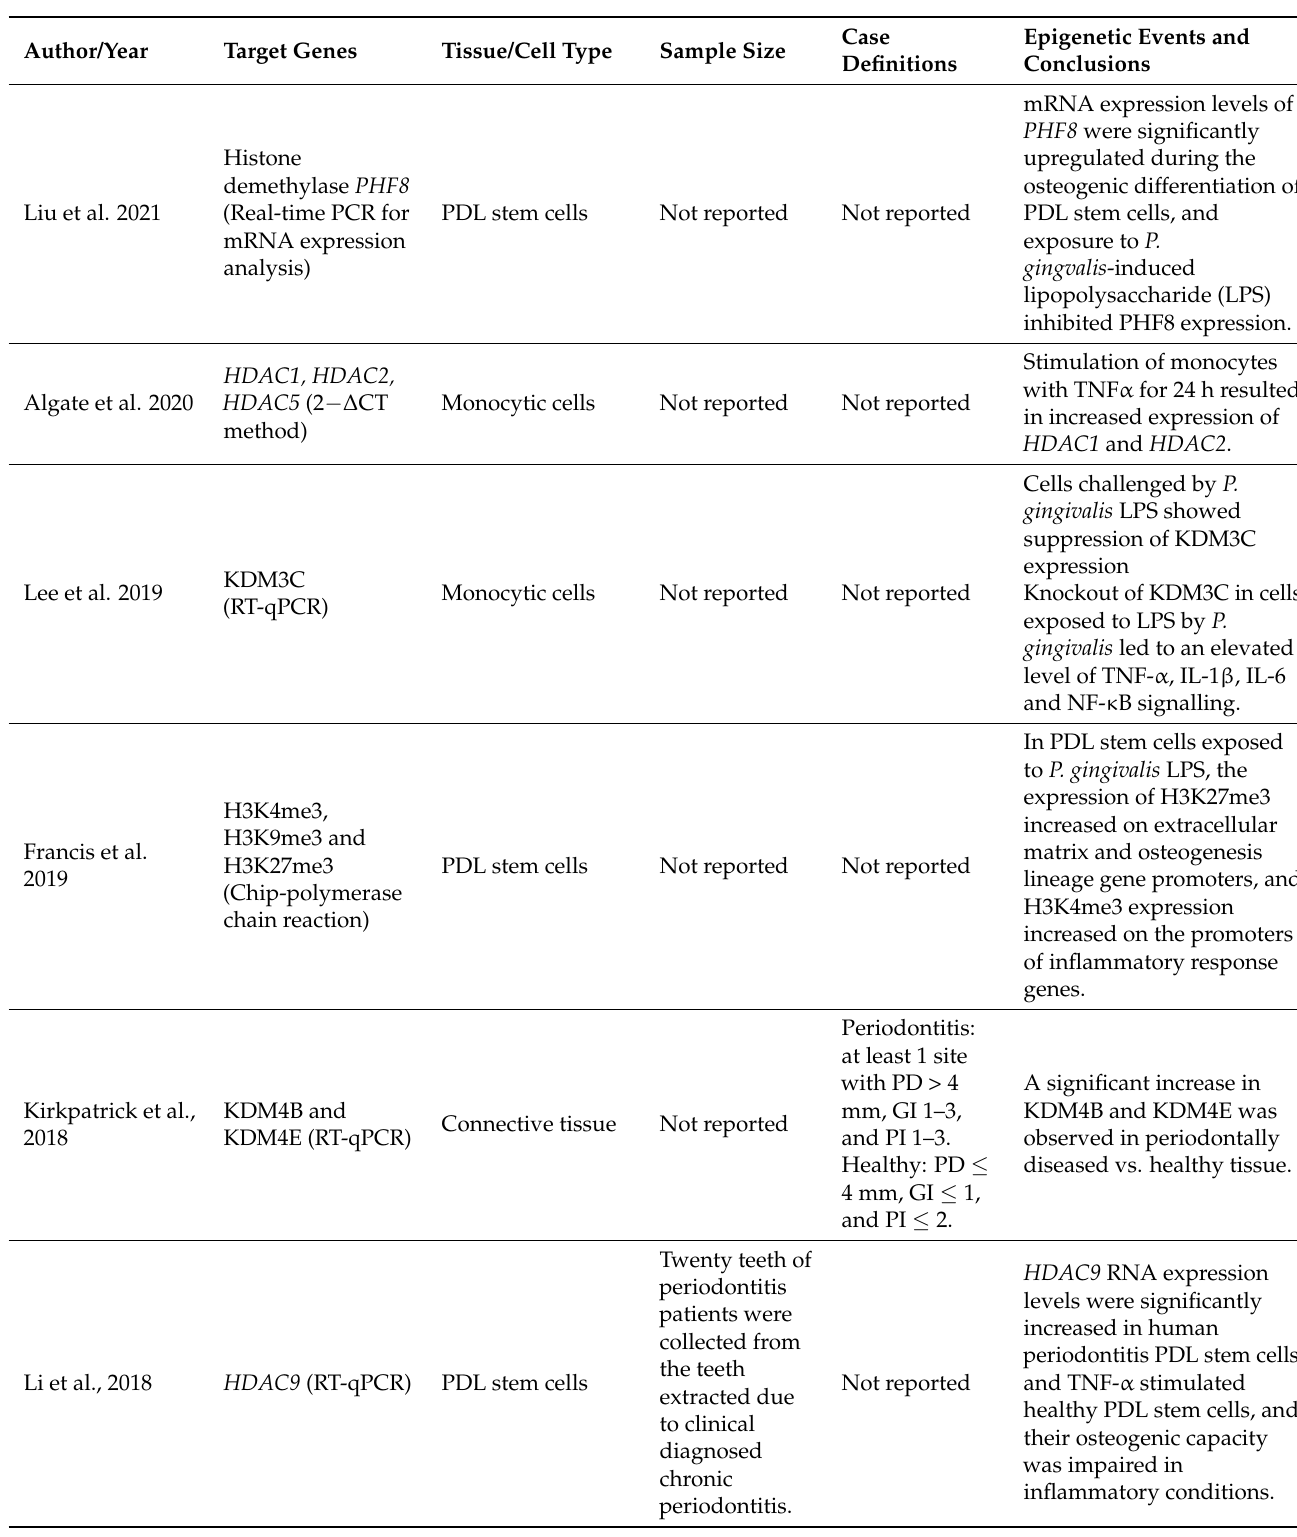
Table 2. Summary of representative publications included for analysis of the periodontitis-histone modification